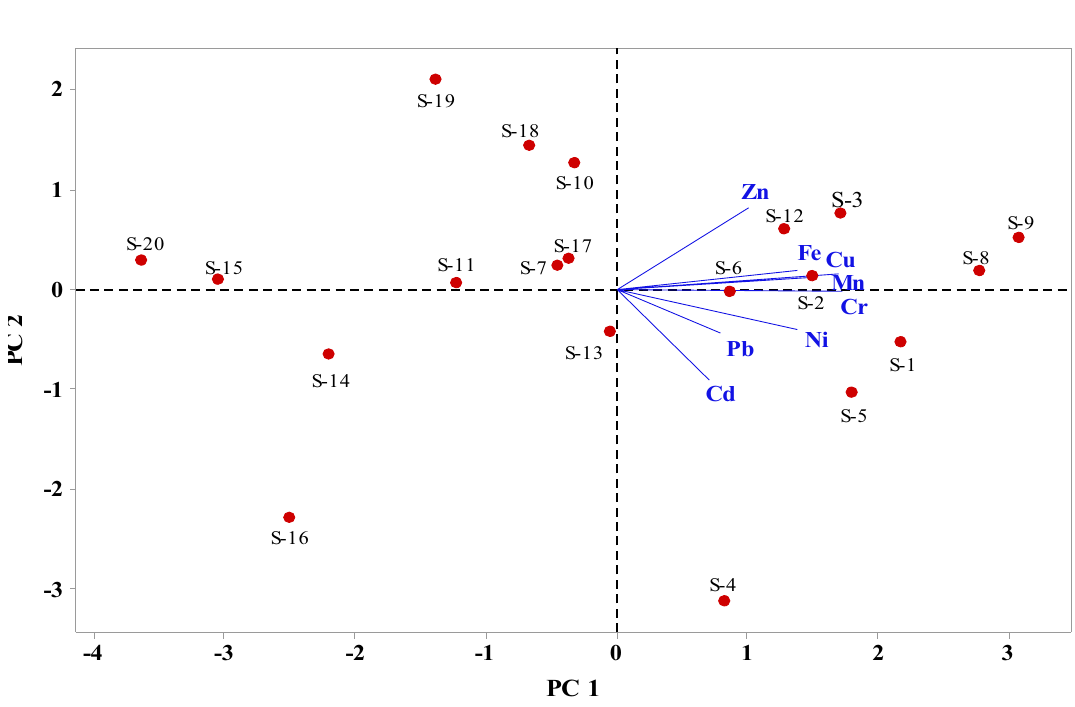
Table 6. Pearson correlation coefficient of trace metals and soil properties in Sundarbans soils. *Indicates significance at 0.05 probability level and **indicates significance at 0.01 probability level.